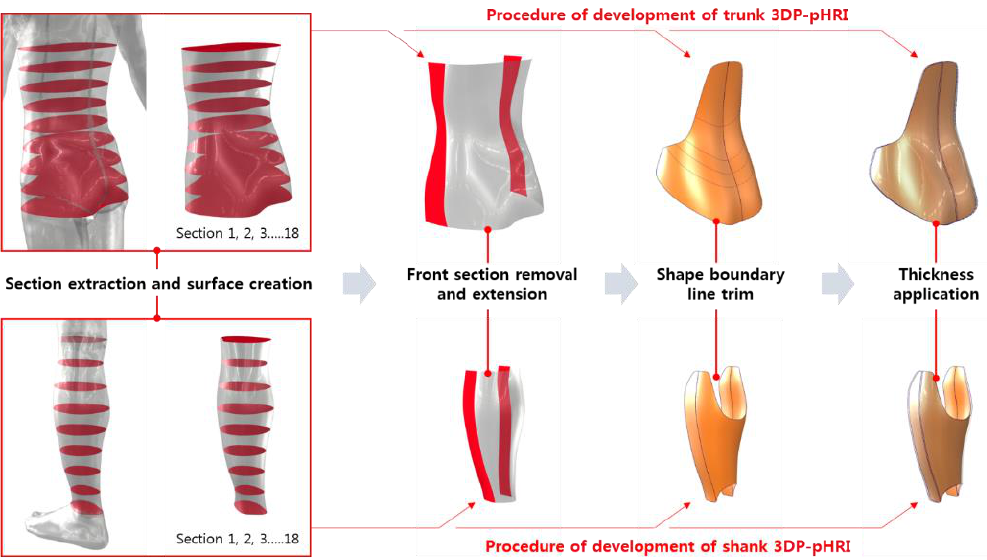
Figure 8. Procedure of development of 3DP-pHRI based on size system.